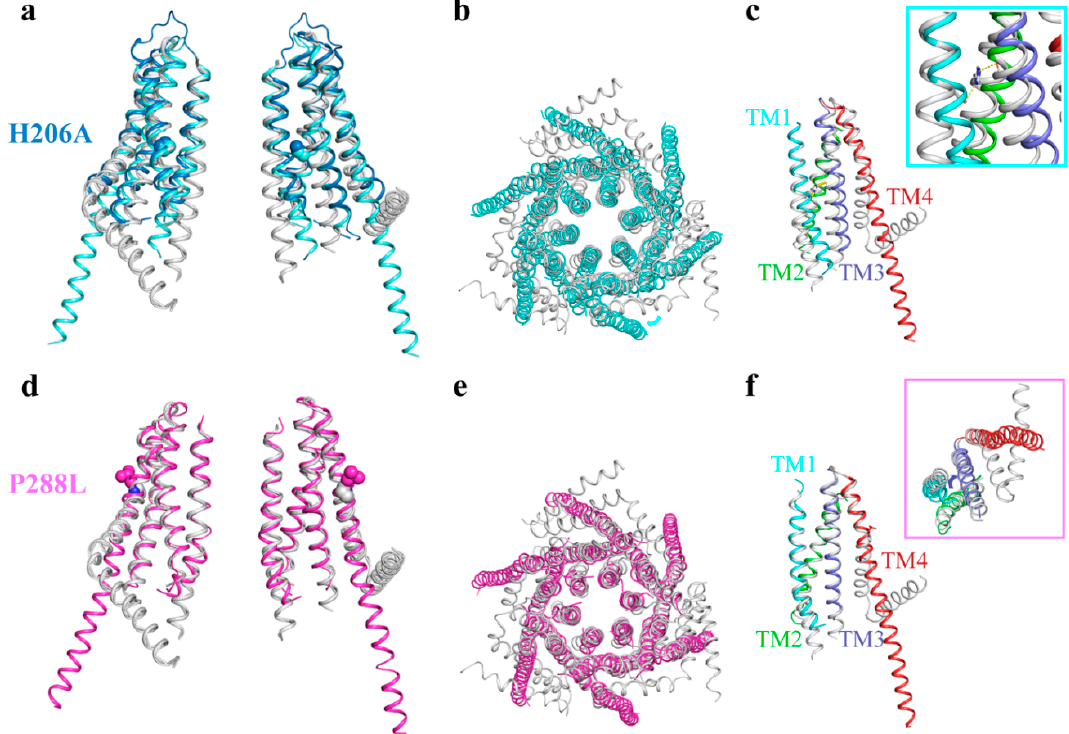
Figure 3. Structures of Orai channel mutants that are constitutively active. ( a ) Cartoon representation of two opposing subunits around the central pore from the structure of the dOrai-H206A mutant channel. Wild-type dOrai (PDB code: 4HKR), dOrai-H206A EM (PDB code: 6BBF) and dOrai-h206A xtal (PDB code: 7KR5) are superimposed together and colored gray, cyan and marine, respectively. Atoms of the H206 residue are shown as balls. ( b ) Top view of the overlay between the wild-type dOrai channel (gray) in a closed state and the dOrai-H206A EM channel (cyan) in an open state. ( c ) Alignment of two monomers from the wild-type dOrai channel (gray) in a closed state and the dOrai-H206A EM channel (multicolor) in an open state. ( d ) Cartoon representation of two opposing subunits from the structure of the dOrai-P288L mutant channel. The wild-type dOrai channel and the dOrai-P288L mutant (PDB code: 6KAI) are colored gray and magenta, respectively. ( e ) Top view of the overlay of the closed (gray) wild-type dOrai and the open (magenta) dOrai-P288L channels. ( f ) Alignment of two protomers from the closed (gray) wild-type dOrai and the open (multicolor) dOrai-P288L